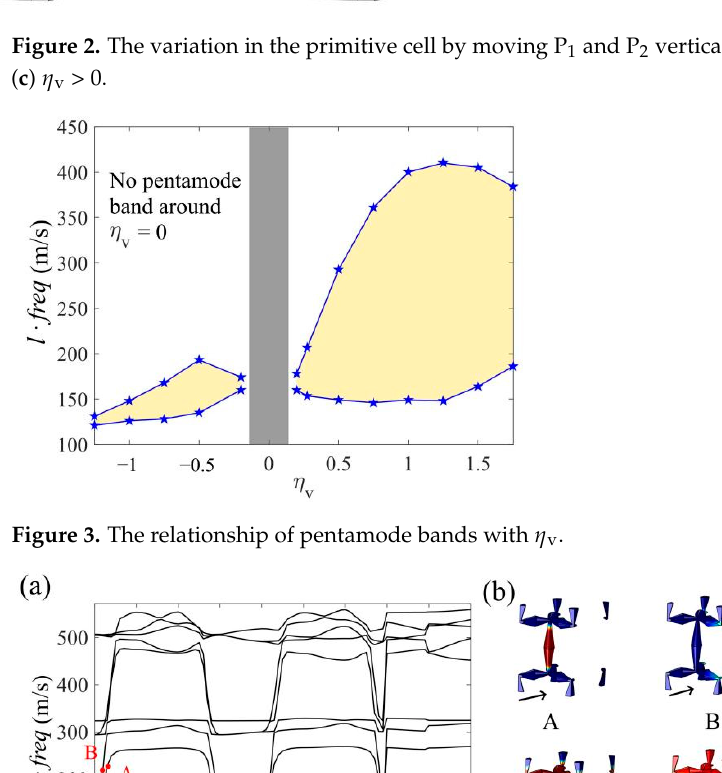
Figure 3. The relationship of pentamode bands with η v . Figure 4. The band structures ( a ) and specific modes ( b ) of the primitive cell with η v = 0.